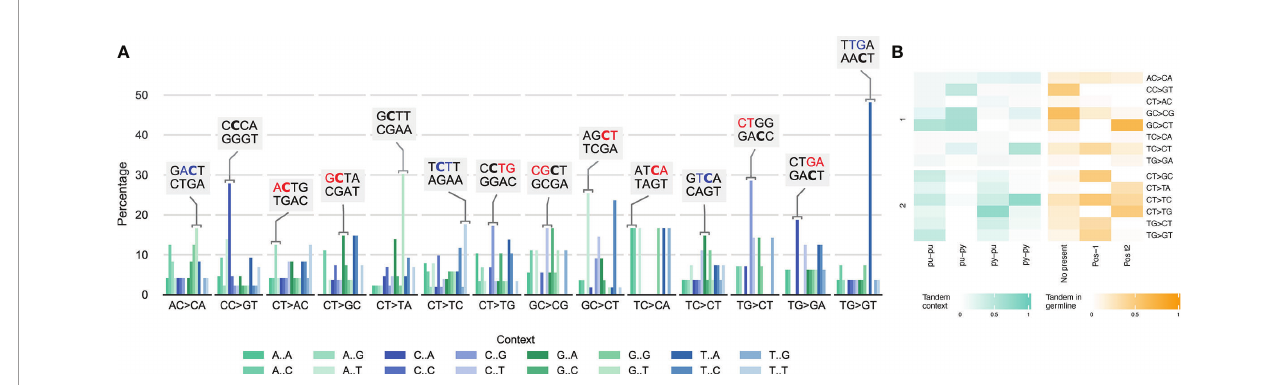
FIGURE 5 | Nucleotide context of tandem dinucleotide substitutions. (A) The 14 most frequently found tandem dinucleotide substitutions (and its reverse complement) in IGHV from the Leiden healthy donor cohort, were grouped by all 16 possible combinations of fl anking nucleotides. Labels displaying the nucleotide context (and reverse complement) with the highest incidence, in red is highlighted the presence of the tandem in the germline reference and underlined and bold the cytosine in the tandem or nearer to the tandem. (B) Tandem germline context analysis (left side, green heatmap). It was performed this analysis considering the base type (py: pyrimidine and pu: purine) using 1 nucleotide before and after the tandem position (the corresponding reference is represented with “ - ” ). Tandem germline context analysis for IGHV sequences (right side, orange heatmap). The presence of the resulting tandem in the germline context was identi fi ed +/-1 nucleotide for the 14 more prevalent tandems (No present: tandem was not found in 4 nucleotide context; Pos -1: tandem was found in position -1 considering the tandem as central positions t1t2; Pos t2: tandem was found in position t2 of the